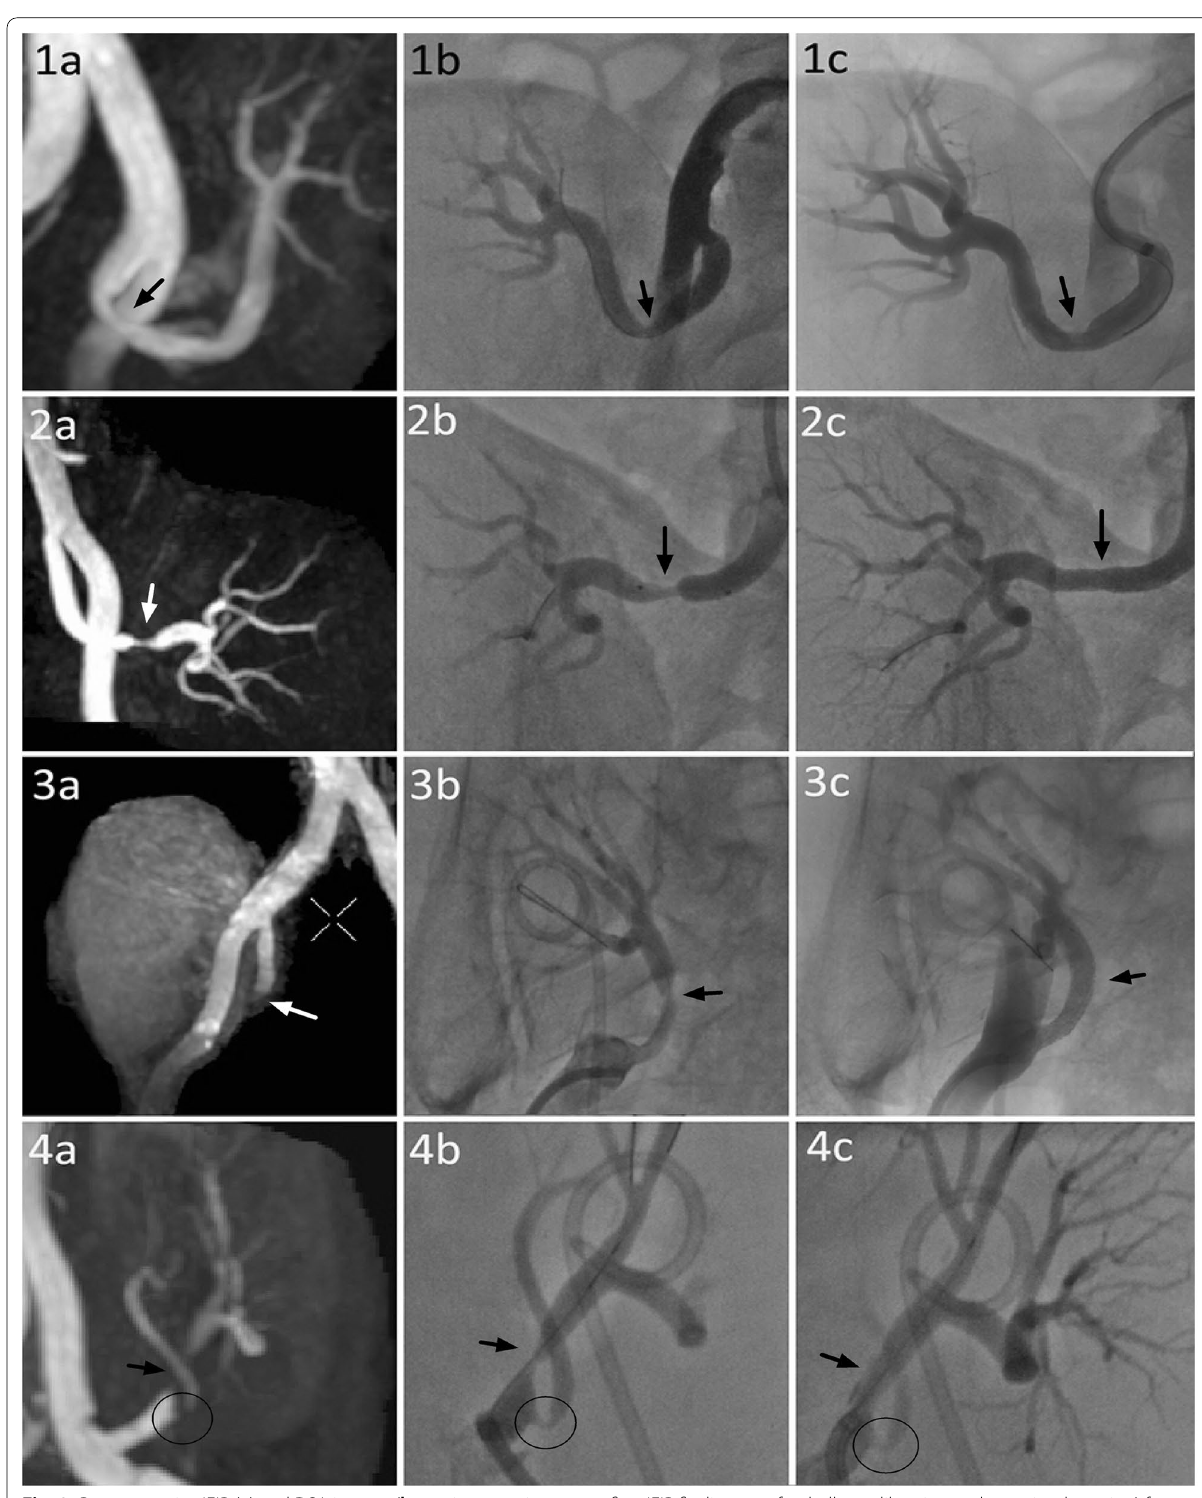
Fig. 3 Representative IFIR ( a ) and DSA images ( b : pre-intervention, to confirm IFIR findings, c : after balloon dilatation and stent implantation) from four patients ( 1 – 4 ) with different degrees of TRAS. Patient 1–2 : Stenosis degree of DSA images were the same with IFIR. Patient 3–4 : IFIR images overestimated the stenosis. Patient 4a–b : An accessory renal artery was seen with initial stenosis, and IFIR produced a satisfactory concordance with